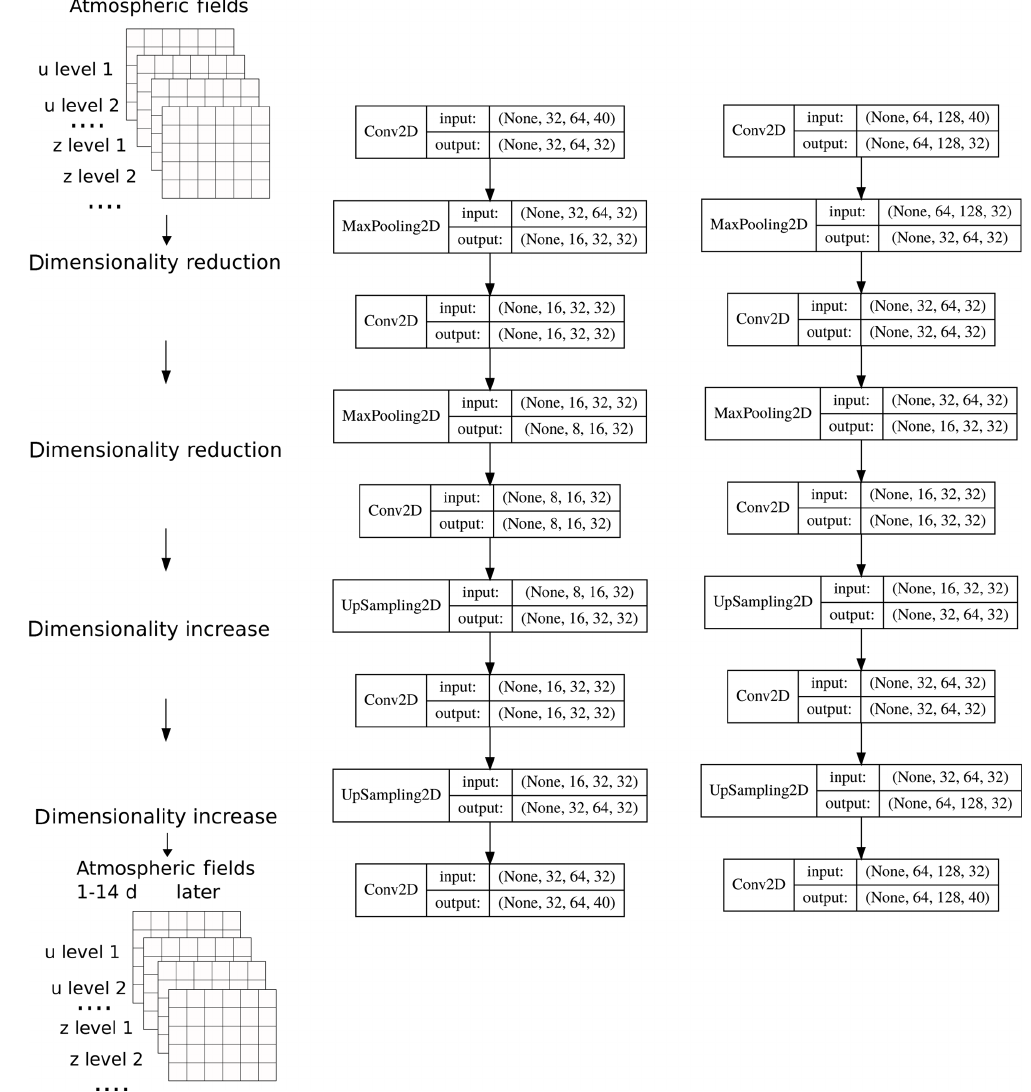
Figure 2. Architecture of the neural network for the models with resolution T21 (left) and T42 (right). Each box describes a network layer, with the numbers indicating the dimension of (None, lat, long, level). “None” refers to the time dimension that is not relevant here but which we include in the schematic since it is part of the basic notation of the software library used. Figure based on Fig. S1 from Scher (2018).